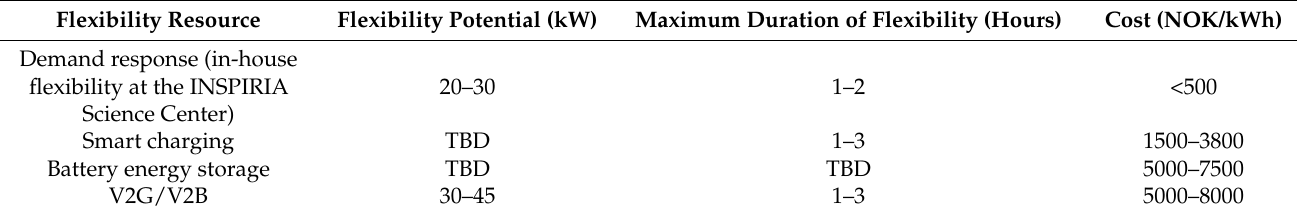
Table 1. Cost and performance for various flexibility